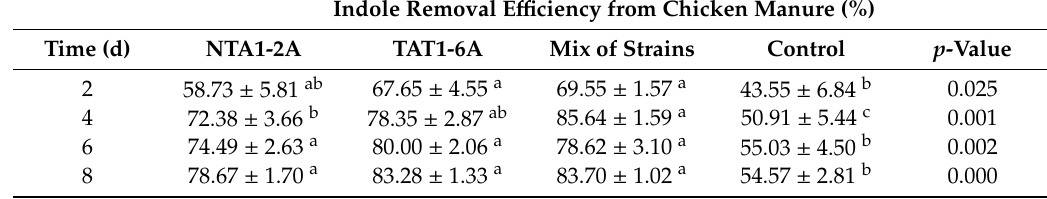
Table 2. Indole removal e ffi ciency of NTA1-2A, TAT1-6A and the mix of strains from poultry manure. Data values are mean ± SD of triplicate